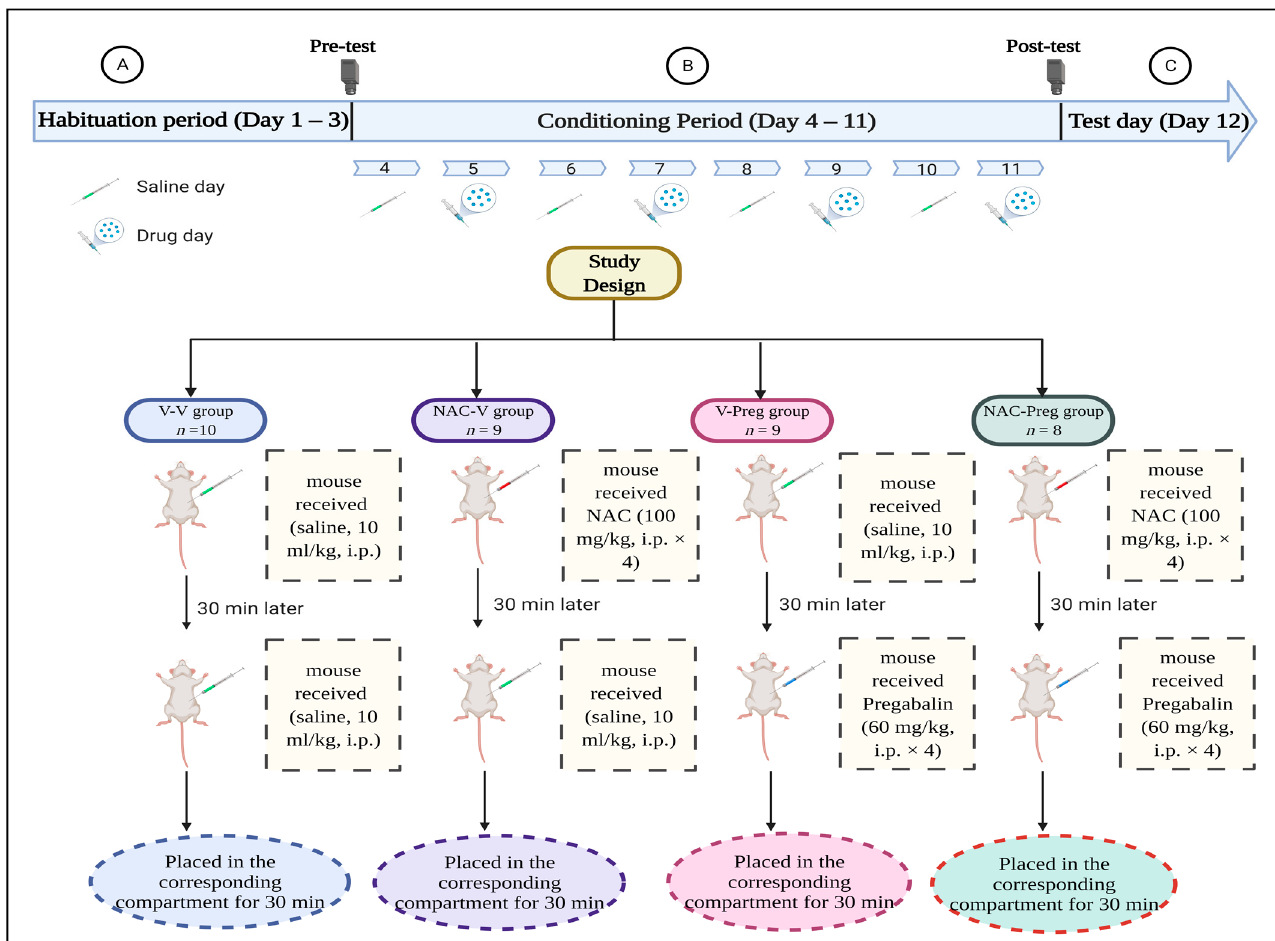
Figure 1. Experimental design to evaluate effect of N-acetylcysteine (NAC) on pregabalin-induced conditioned place preference (CPP). ( A ) Each mouse was permitted to explore both conditioning compartments for 30 min and was tested at Day 3. ( B ) During the conditioning period, each mouse received two injections/day of either saline or NAC (100 mg/kg) in the home cage as a 30 min pretreatment, followed by pregabalin (60 mg/kg) or vehicle. The next day, each mouse received two injections/day of only the vehicle as pre- and post- treatment, and that was repeated for 8 days. ( C ) At Day 12, post-test was conducted.